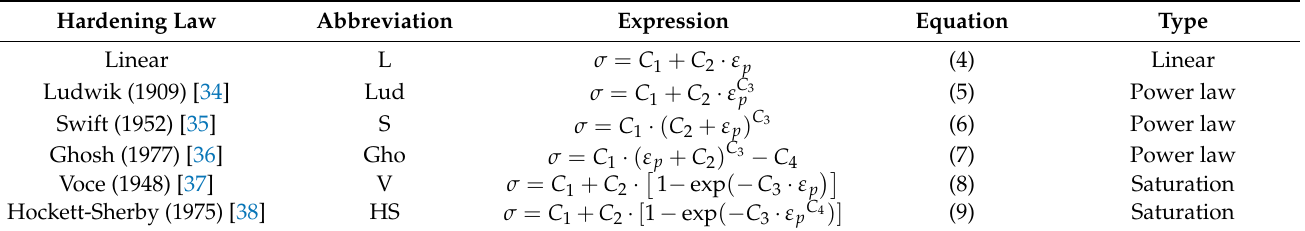
Table 2. Calibration results of hardening models.